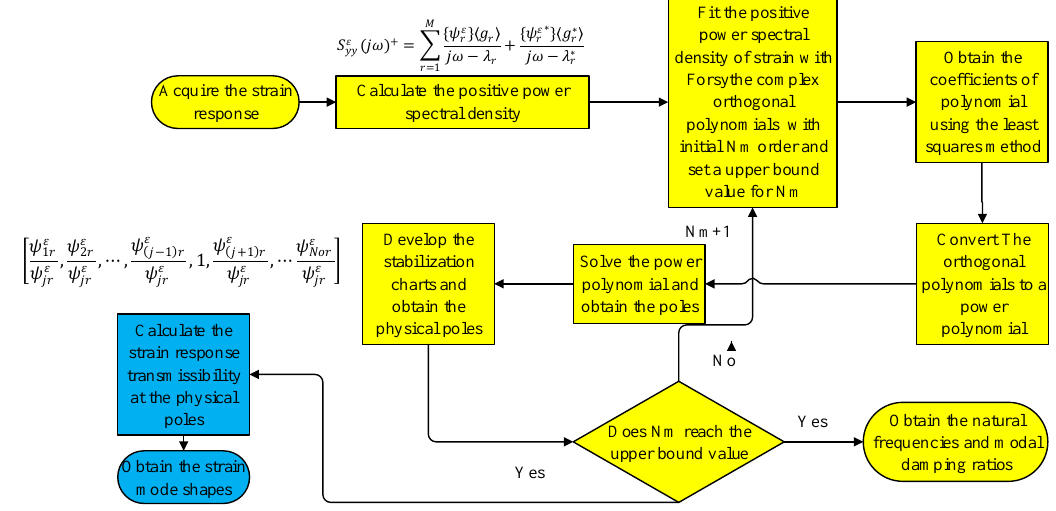
Figure 1. The novel diagram of the presented method for Figure 1 . The novel diagram of the presented method for OMA.